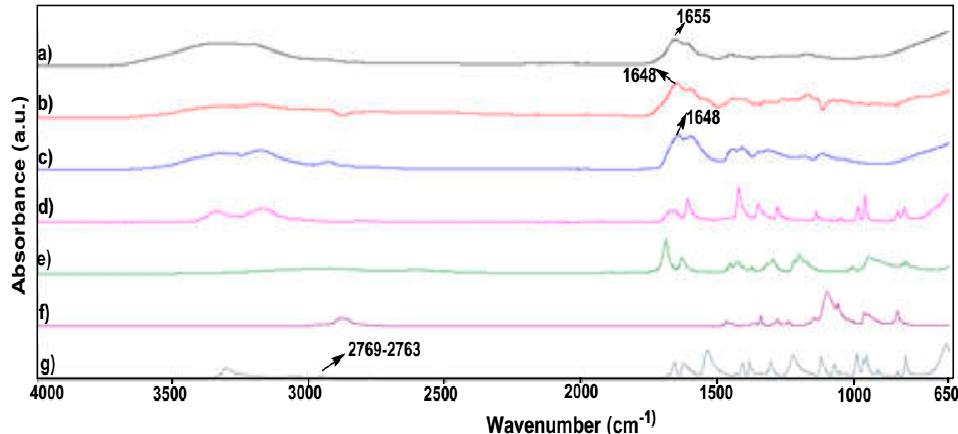
Figure 1. Infrared spectra of (a) synthesized hydrogel; (b) lyophilized hydrogel; (c) polyacrylamide; (d) acrylamide; (e) methylacrylamide; (f) pluronic F-127 and (g) MBA.